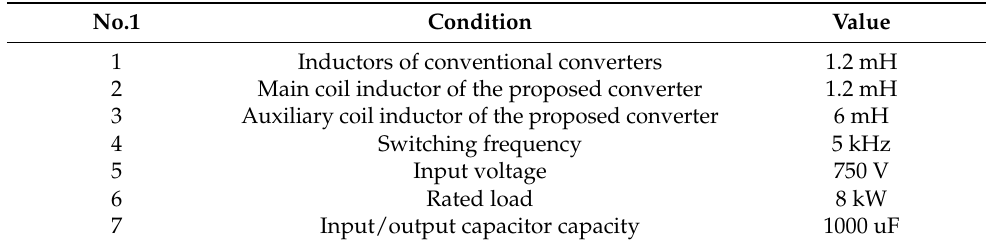
Figure 7. Inductor value model result of heterogeneous reactor.